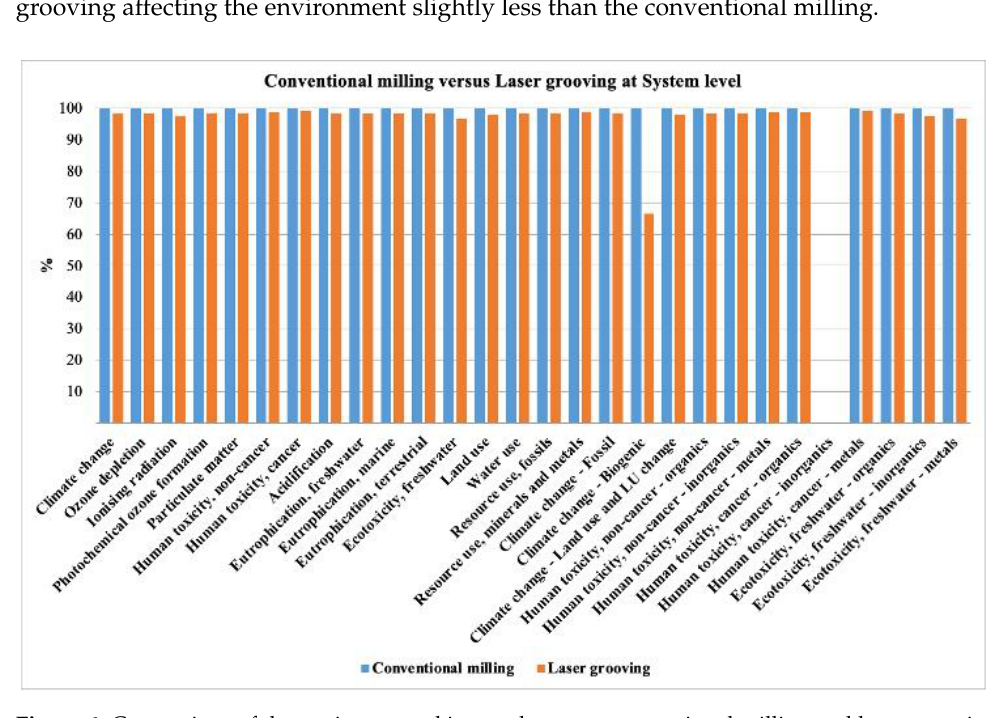
Figure 6. Comparison of the environmental impact between conventional milling and laser grooving at system level.